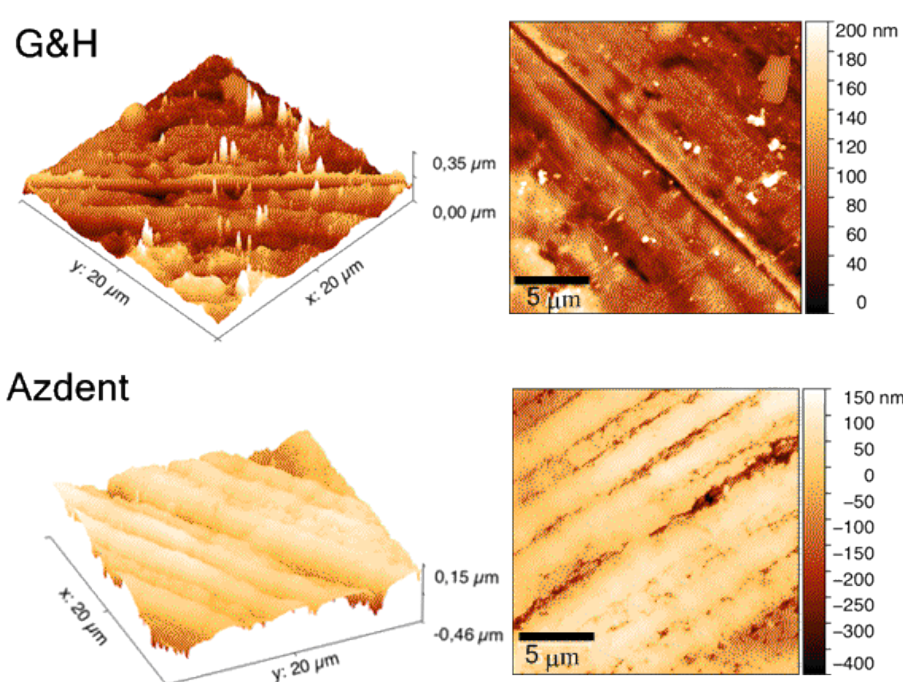
Figure 6. Atomic force microscopy (AFM) measurements of G&H ( upper ) and Azdent ( lower ) stainless steel archwires. Both 3D ( left ) and 2D ( right ) reconstructions of the surface morphology, (scale bar 5 µ m), are shown. Azdent (lower) shows a much larger range deviation ( ∆ 0.61 µ m vs. 0.35 µ m for G&H) over matching domains (400 µ m 2 ), evidencing more pronounced grooving and pitting; in agreement with the SEM